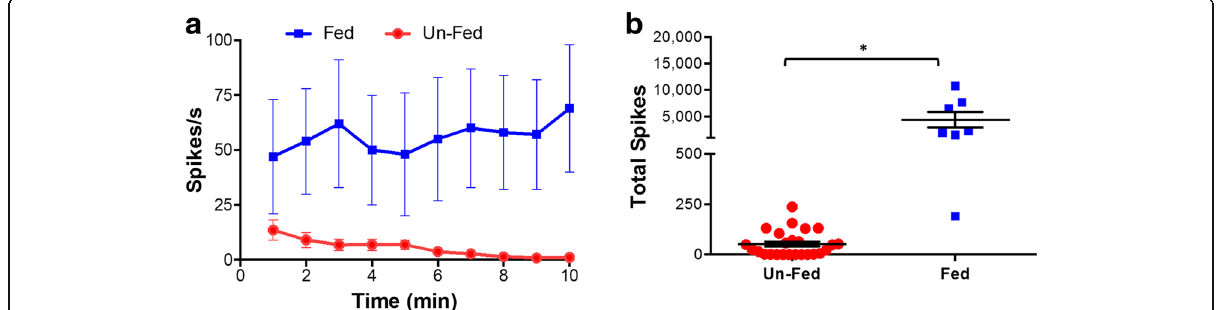
Fig. 5 The effect of food intake on the baseline vagus nerve activity. a Plot of fed mice ( n =8, solid line, closed circles) and un-fed mice ( n =25, dashed line open boxes) shows significant differences at all time points ( p <0.05). b Total spike count over the entire 10-min recording in un-fed and fed mice (T-test p< 0.0001)